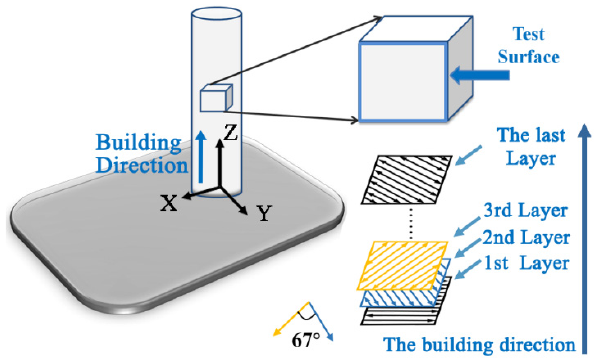
Figure 1. Schematic illustration of the SLM- and EBM-manufactured Ti-6Al-4V specimens built in the vertical direction.